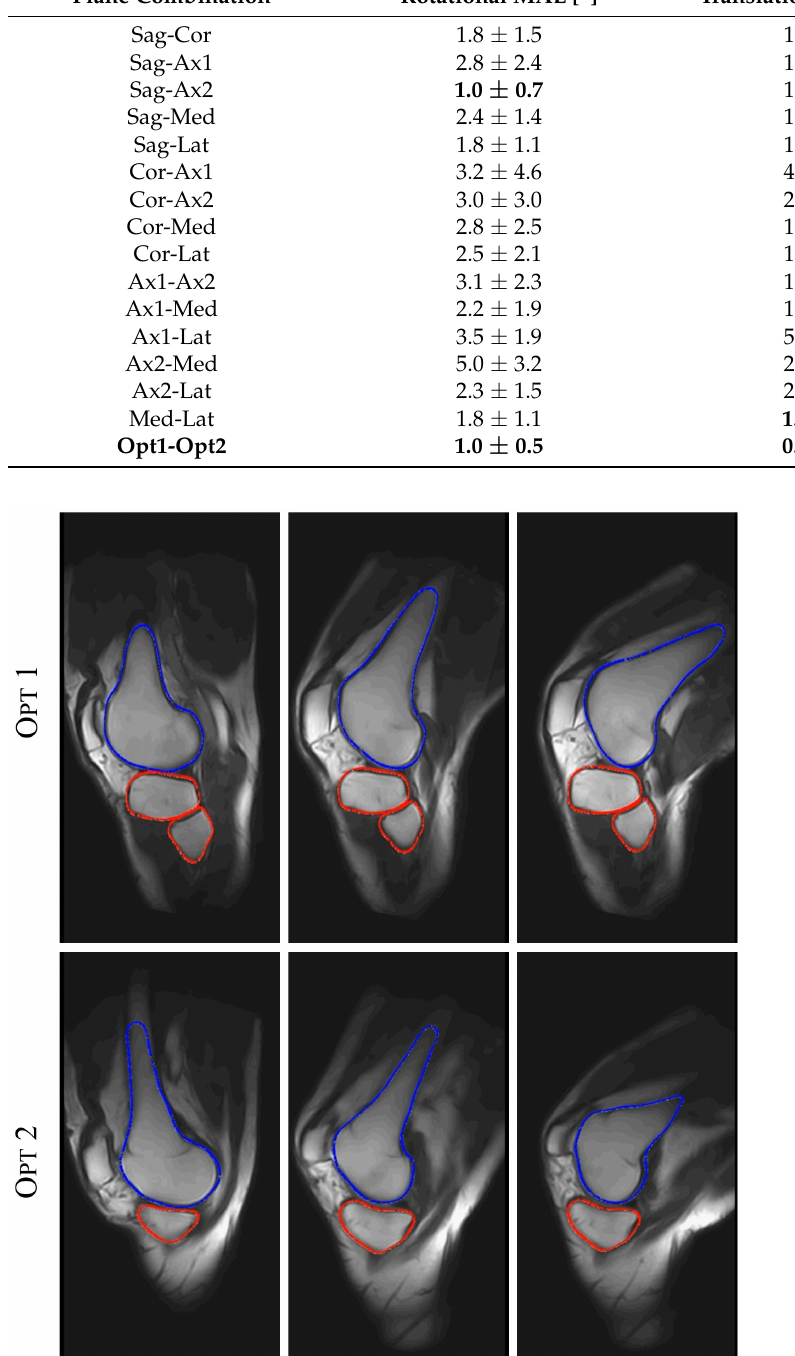
Figure 6. Representation of the bone registration, on the two optimal DMRI planes, at different flexion angles. The registered femur intersection with the planes is depicted in blue, while the tibia–fibula complex intersection is depicted in red.